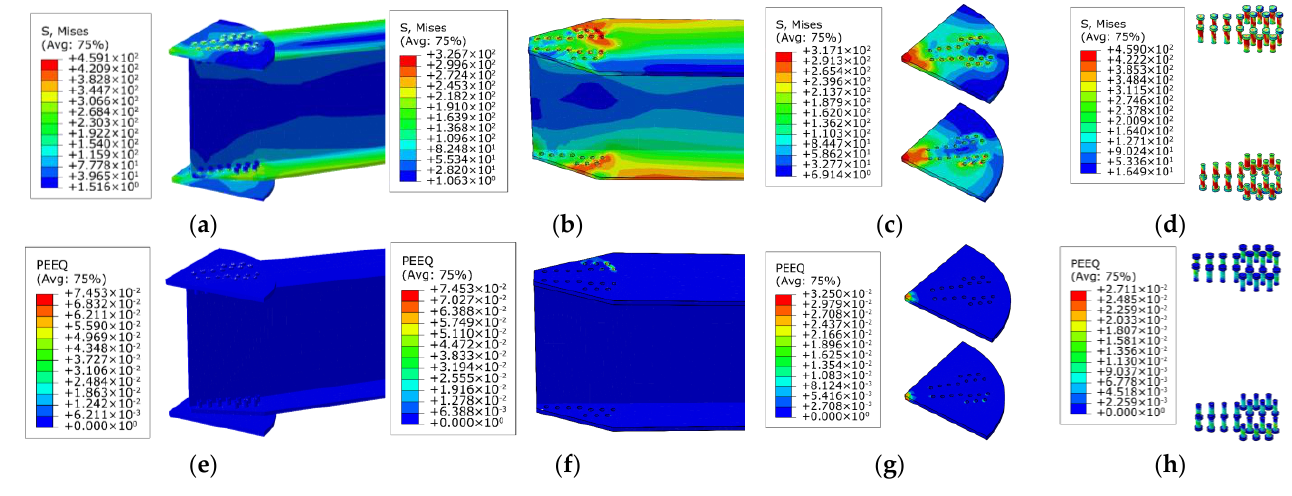
Figure 10. Stress cloud and plastic strain map of the benchmark model. ( a ) Stress cloud of the AAG joint; ( b ) stress cloud of member; ( c ) stress cloud of joint plates; ( d ) stress cloud of bolts; ( e ) plastic strain of the AAG joint; ( f ) plastic strain of member; ( g ) plastic strain of joint plates; ( h ) plastic strain of bolts.